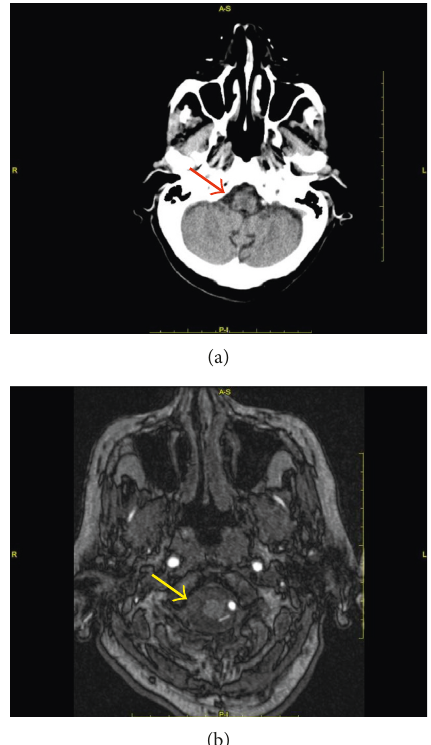
Figure 2: Brain CT scan (a) and MRI (b) showing the complete occlusion (arrows) of the right intracranial vertebral